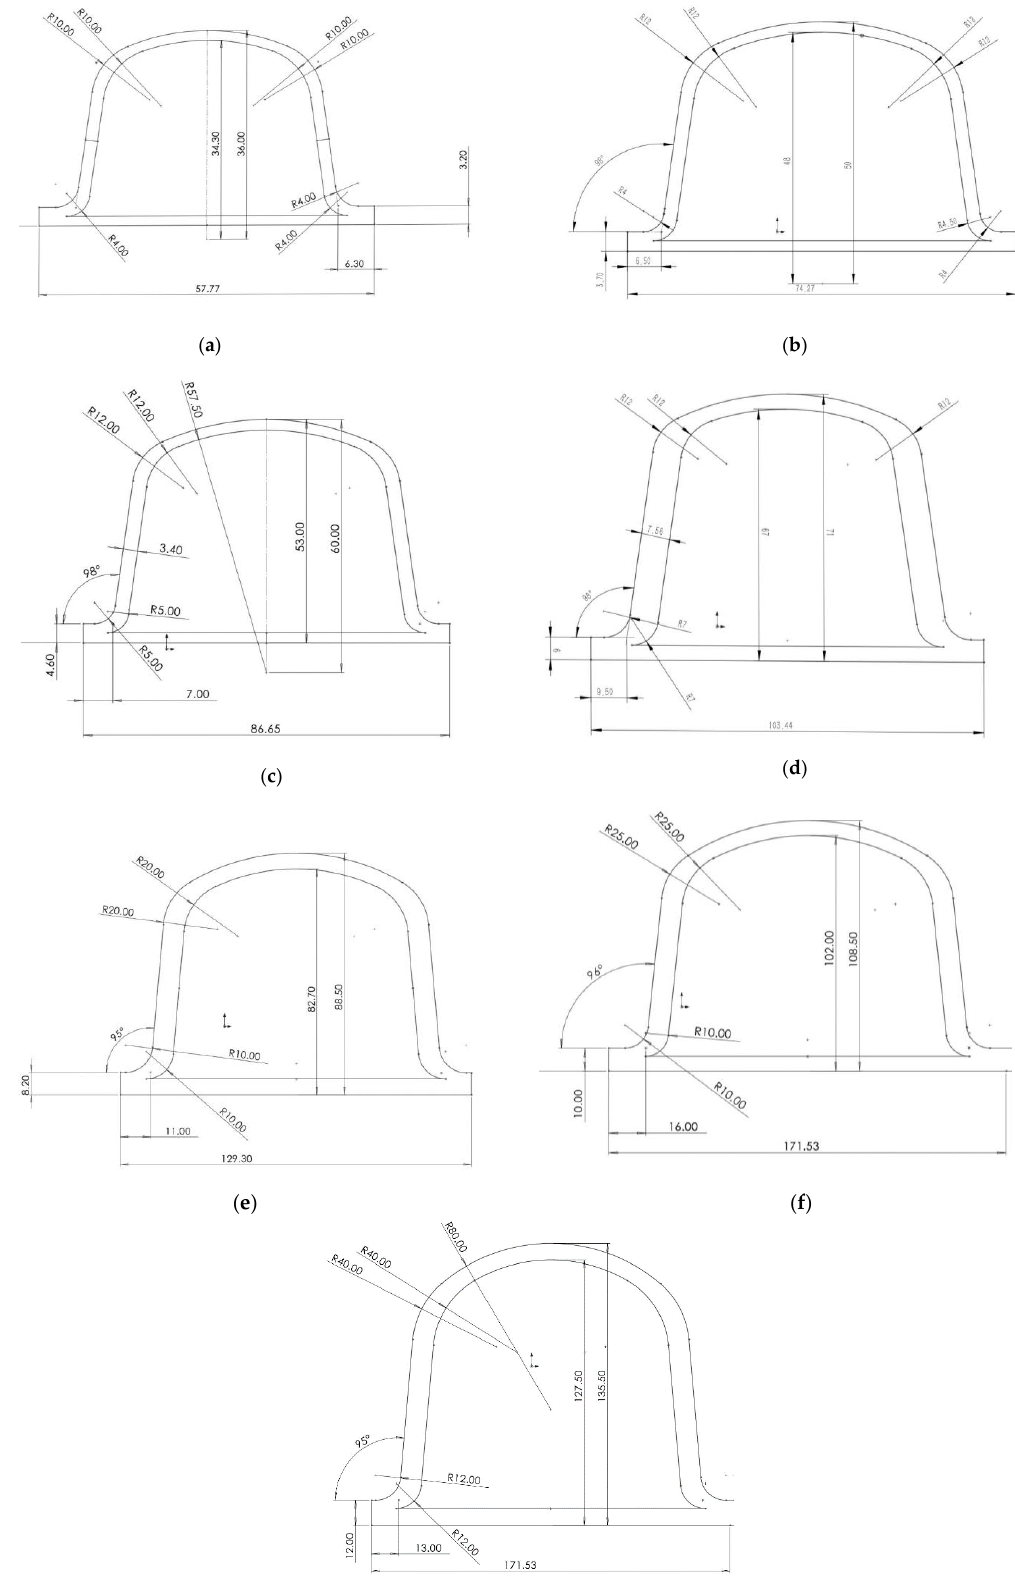
Figure 9. The waveforms of bellows with different diameters as follows: ( a ), 400 mm; ( b ), 500 mm; ( c ), 600 mm; ( d ), 800 mm; ( e ), 1000 mm; ( f ), 1200 mm; ( g ), 1500 mm. Figure 10a is a displacement diagram of the bellows ring stiffness test model. The direction represented by the yellow arrow is the displacement direction of the upper steel plate. Figure 10b is a schematic diagram of the reaction force of the bellows to the steel plate during compression. The reaction force on the upper steel plate could be calculated by Ansys Workbench software (Version 2020 R2, Ansys, Washington, PE, USA). Tthe ring stiffness of the bellows could be calculated by substituting the reaction force into formula (1)